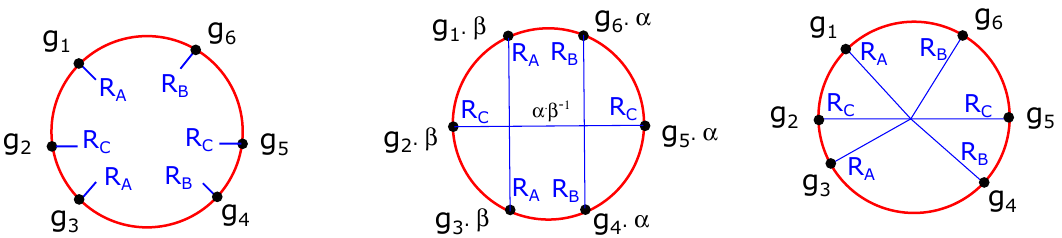
Figure 16 . Left: particle-on-a-group evaluation. Middle: choice of group elements that agrees with the bulk BF computation. Right: bulk interpretation of the particle-on-a-group